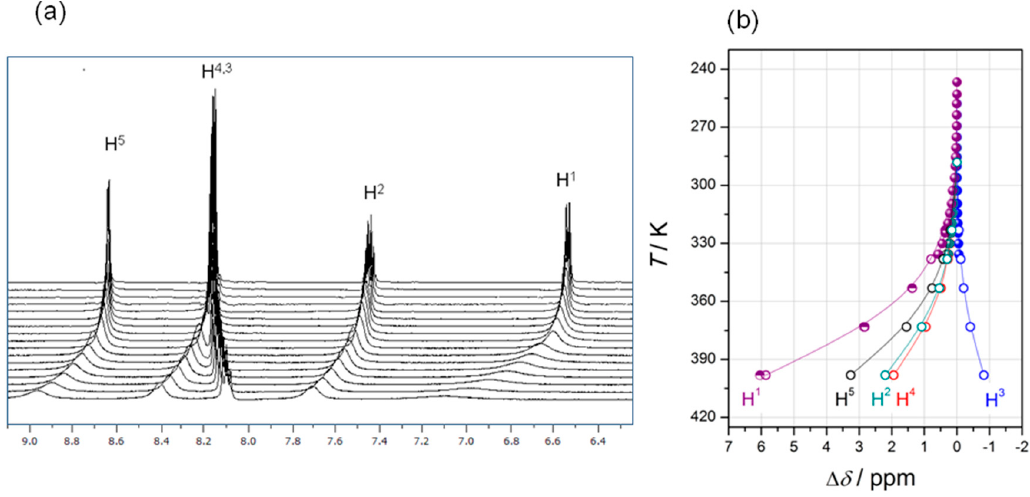
Figure 5. ( a ) VT- 1 H-NMR spectra of [FeL] (BF 4 ) 2 (400 MHz; [D 3 ]MeCN; zoom on “aromatic protons”; intensities are not to scale; ( b ) temperature-dependent drift of resonances due to H 1 − 5 in [FeL] (BF 4 ) 2 (for proton assignment, see Scheme 1); open symbols: [FeL] (BF 4 ) 2 (500 MHz; [D 5 ]nitrobenzene); half-filled symbols: [Fe(tren)py 3 ] (ClO 4 ) 2 (H 1 ; 500 MHz; in [D 5 ]nitrobenzene).